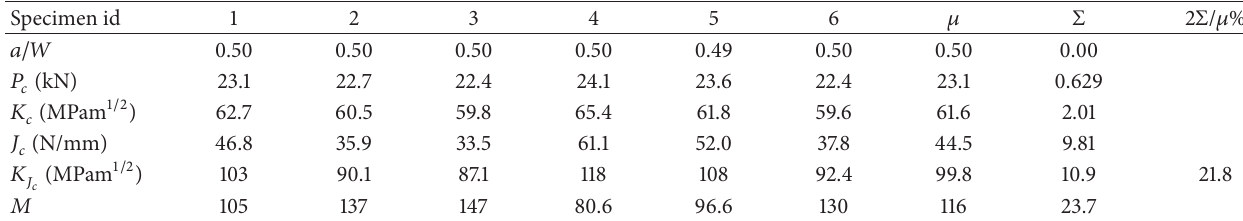
Figure 4: Dimensions of the 25t SE(B) specimen. Table 1: Fracture toughness test results of S55C steel with 25t SE(B) specimen tested at 20 ∘ C. Here, 𝜇 and Σ in the table denote the mean and standard deviation of each